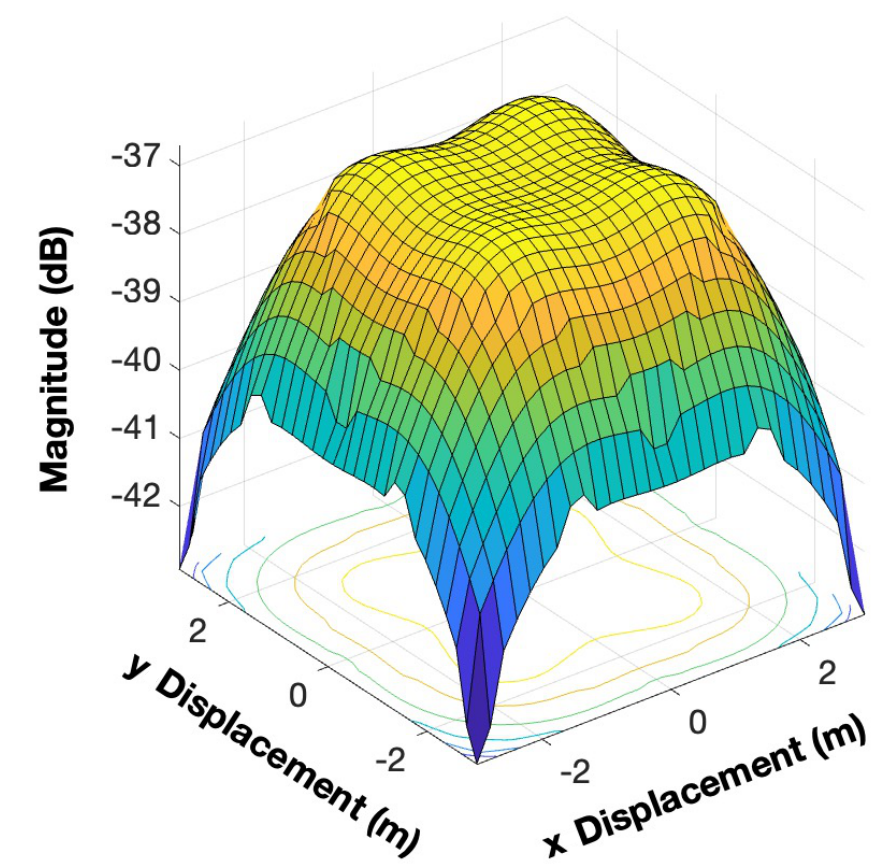
Figure 1. Lambertian simulation for total Rx power for φ = 30 ◦ , ψ = 30 ◦